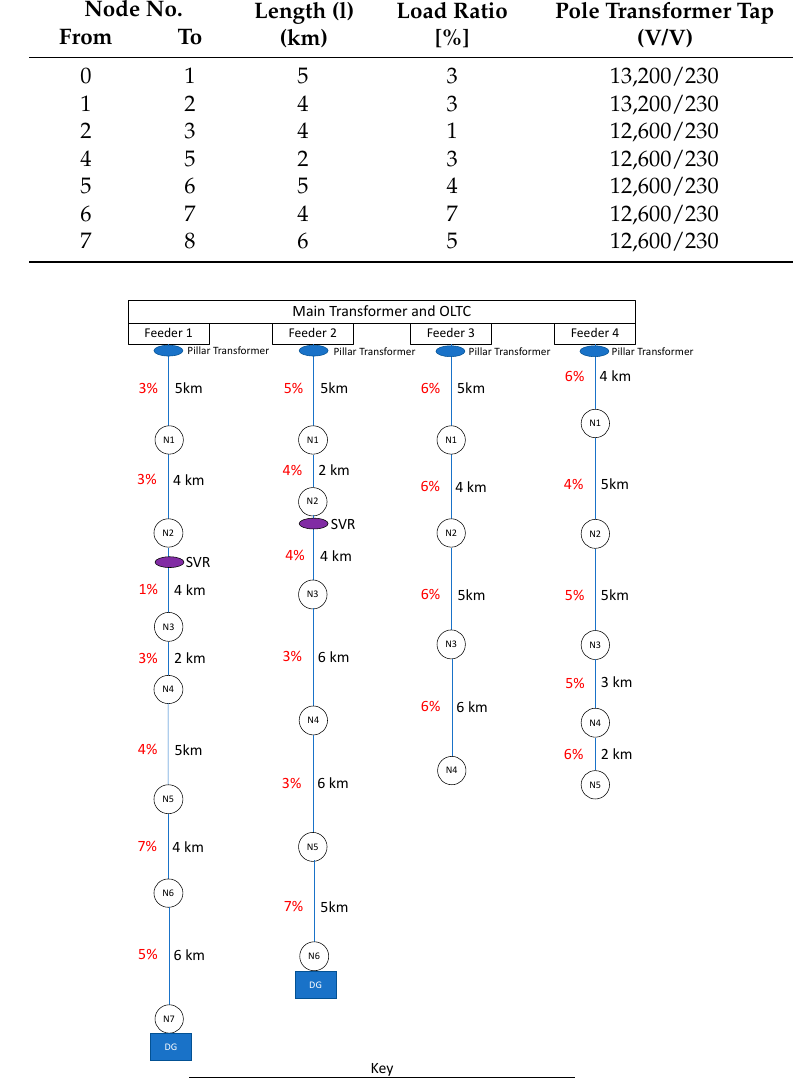
Table 1. High-voltage distribution line section data for Feeder 1 Node No. Load Ratio